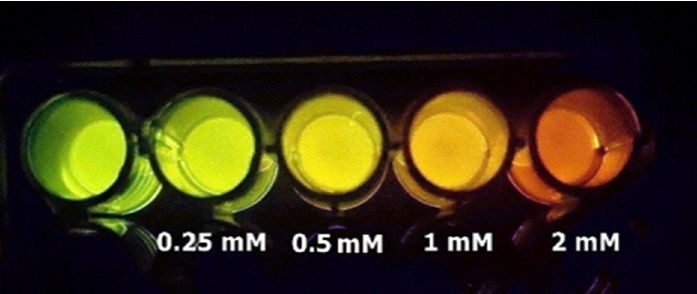
Figure 12. Smartphone detection of bioluminescence color tuning by cadmium, using Amydetes viviani firefly luciferase.